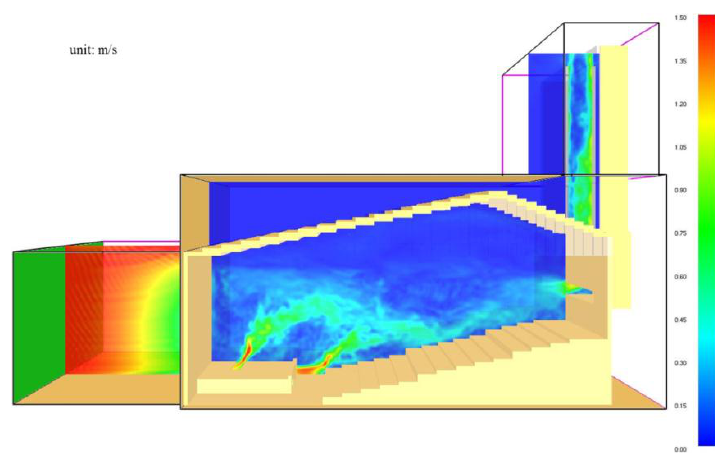
Figure 11. Velocity profile of the normal ventilation.